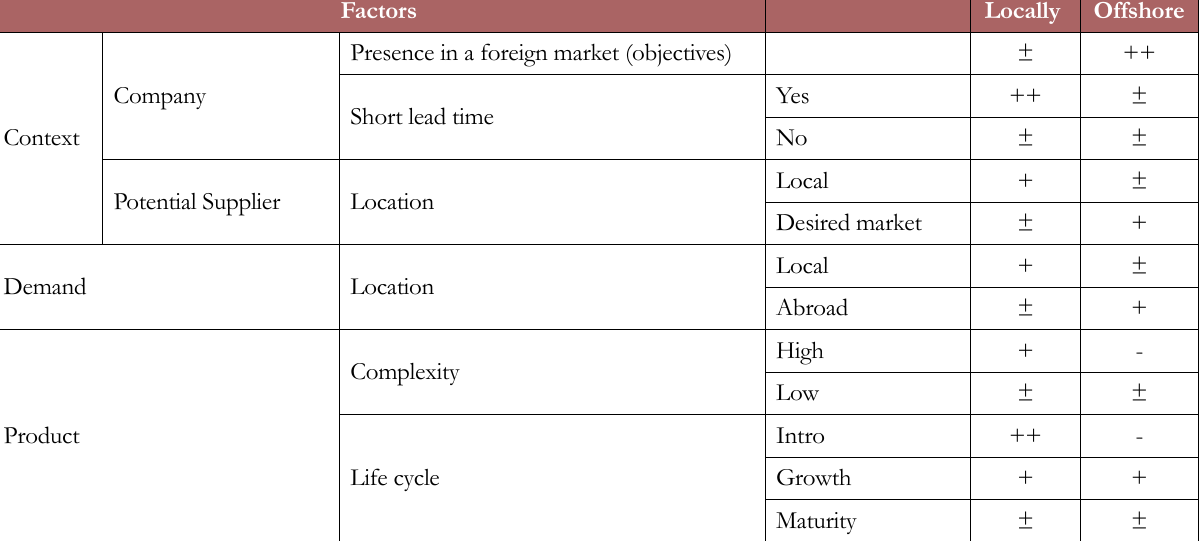
Table 5. Evaluation of the relevant factors for selecting the sourcing